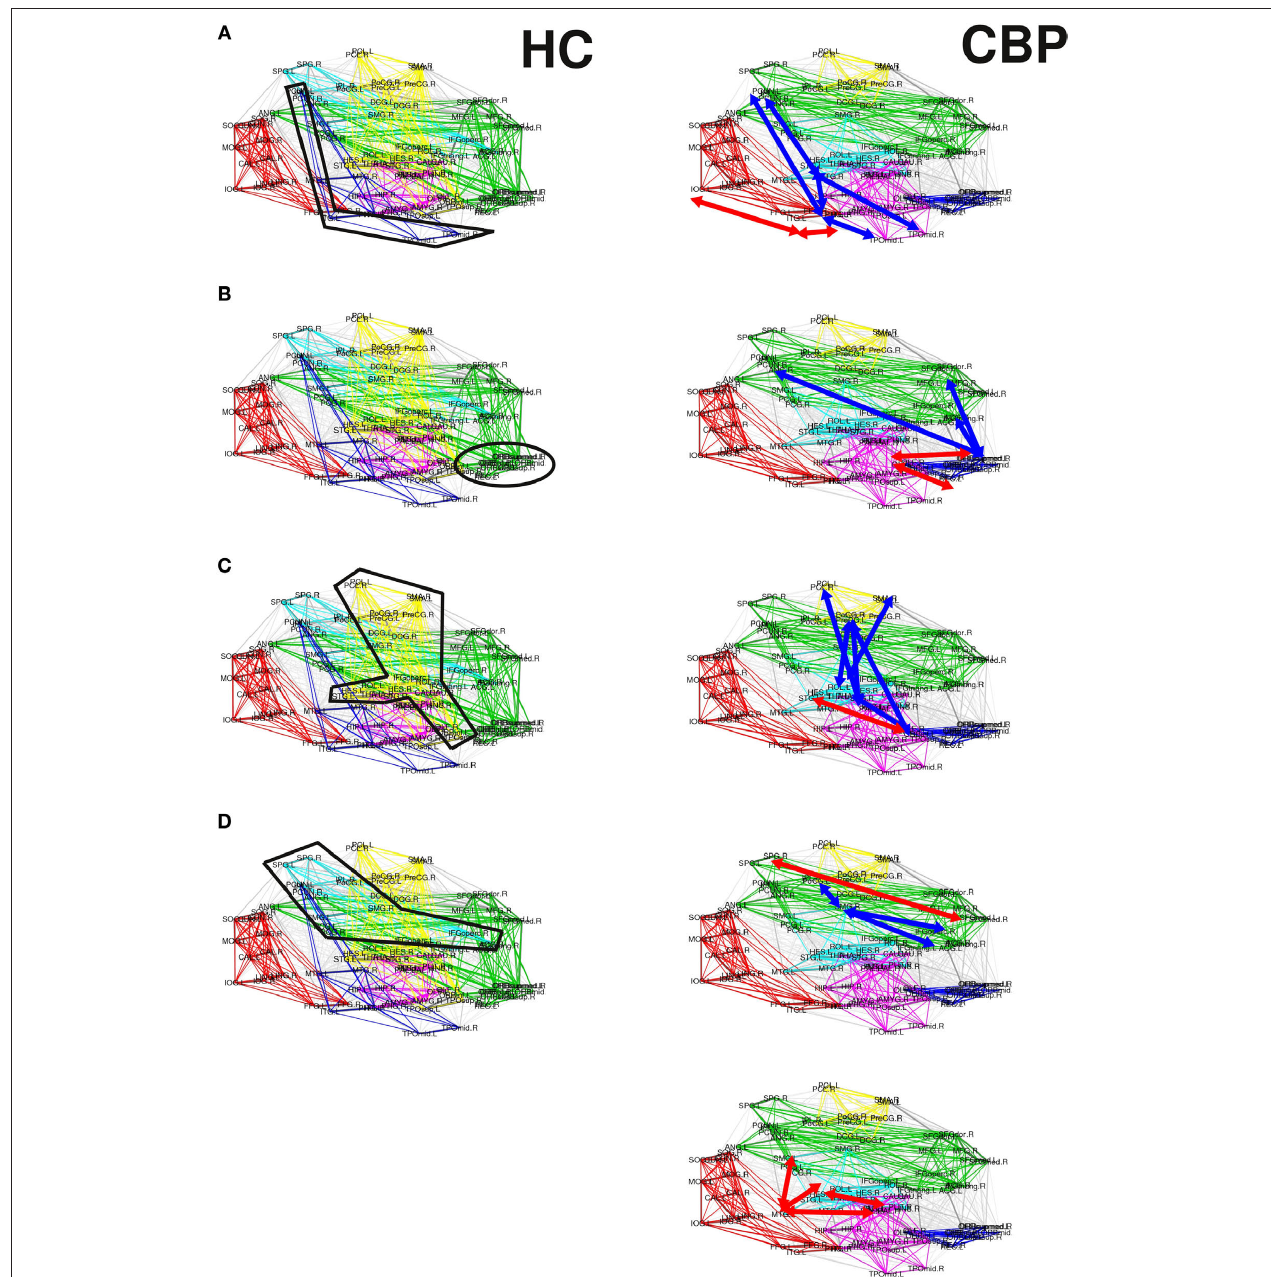
Figure 5 | Summary of the alterations in pairwise correlations driving the observed changes in the reorganization of the CBP networks. HC and CBP partitions are shown in left and right columns respectively. Changes associated with the parieto-temporal, fronto-medial, and sensorimotor communities are